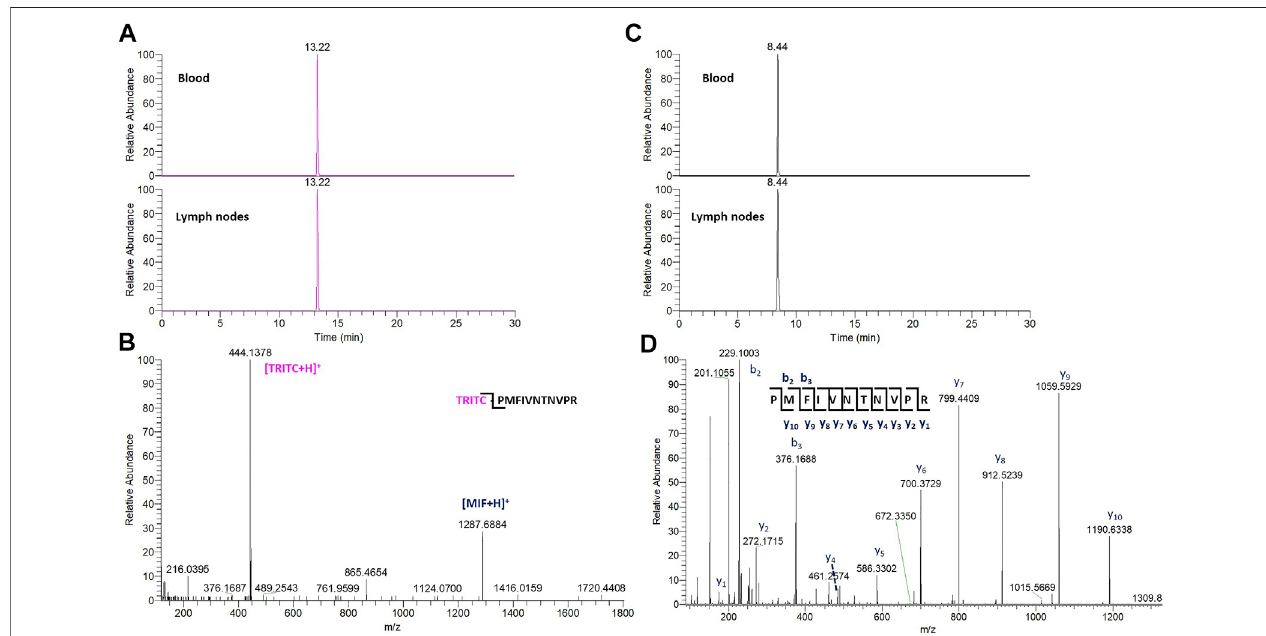
FIGURE 5 | (A) TIC of the characteristic TRITC fragment from the TRITC-MIF peptide in blood and lymph node sample. (B) Representative MS 2 spectra of the TRITC-MIFpeptide. (C) TICofacharacteristicyionfragmentfromtheMIFpeptideinthesamebloodandlymphnodesample. (D) RepresentativeMS 2 spectraoftheMIF